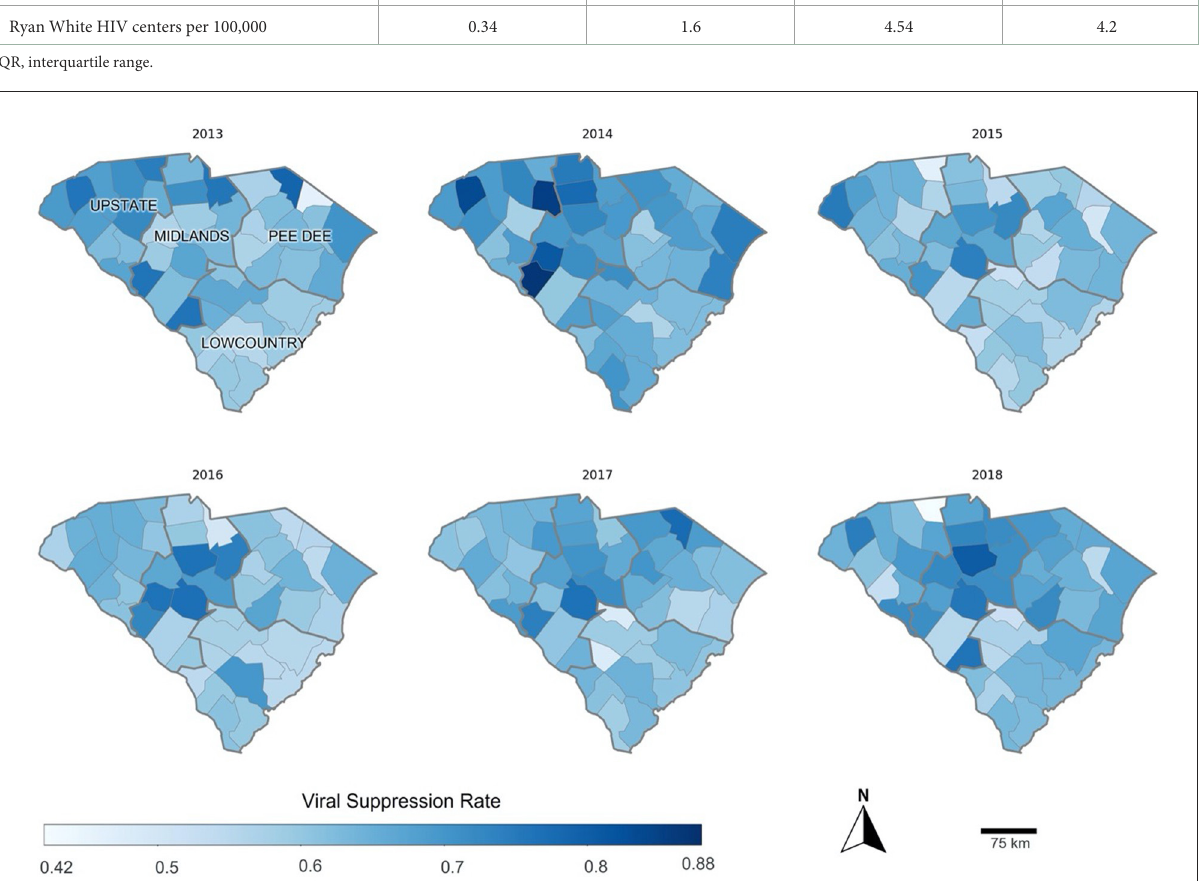
FIGURE1 The viral suppression rate across 46 counties in South Carolina from 2013 to